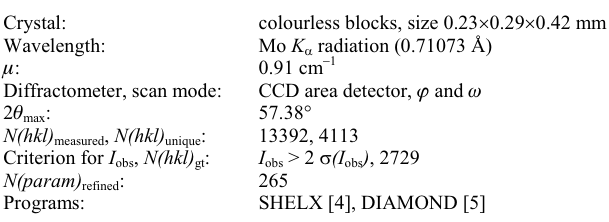
Table 1. Data collection and handling.